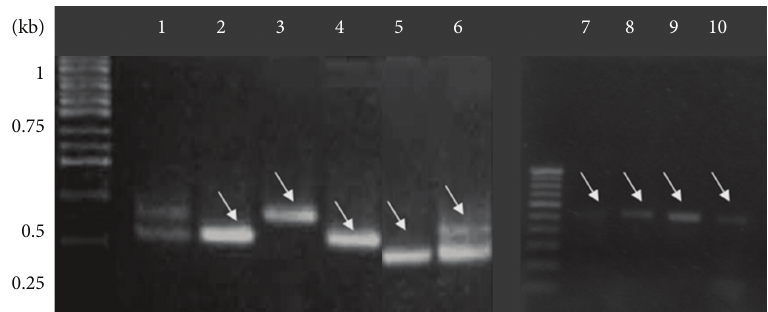
Figure 5: PCR amplification of the fragile site regions present within the FRA11F fragile site locus on chromosome 11q13 in humans. Lane 1 has the positive control for PCR amplification. Lane 2 and lane 4: PCR amplicon of 546 bp corresponding to FRAI. Lane 3: band of mol. wt. 689 bp corresponding to FRA II. Lanes 7–10: reamplified FRAI sequence. M is the 1kb DNA ladder.